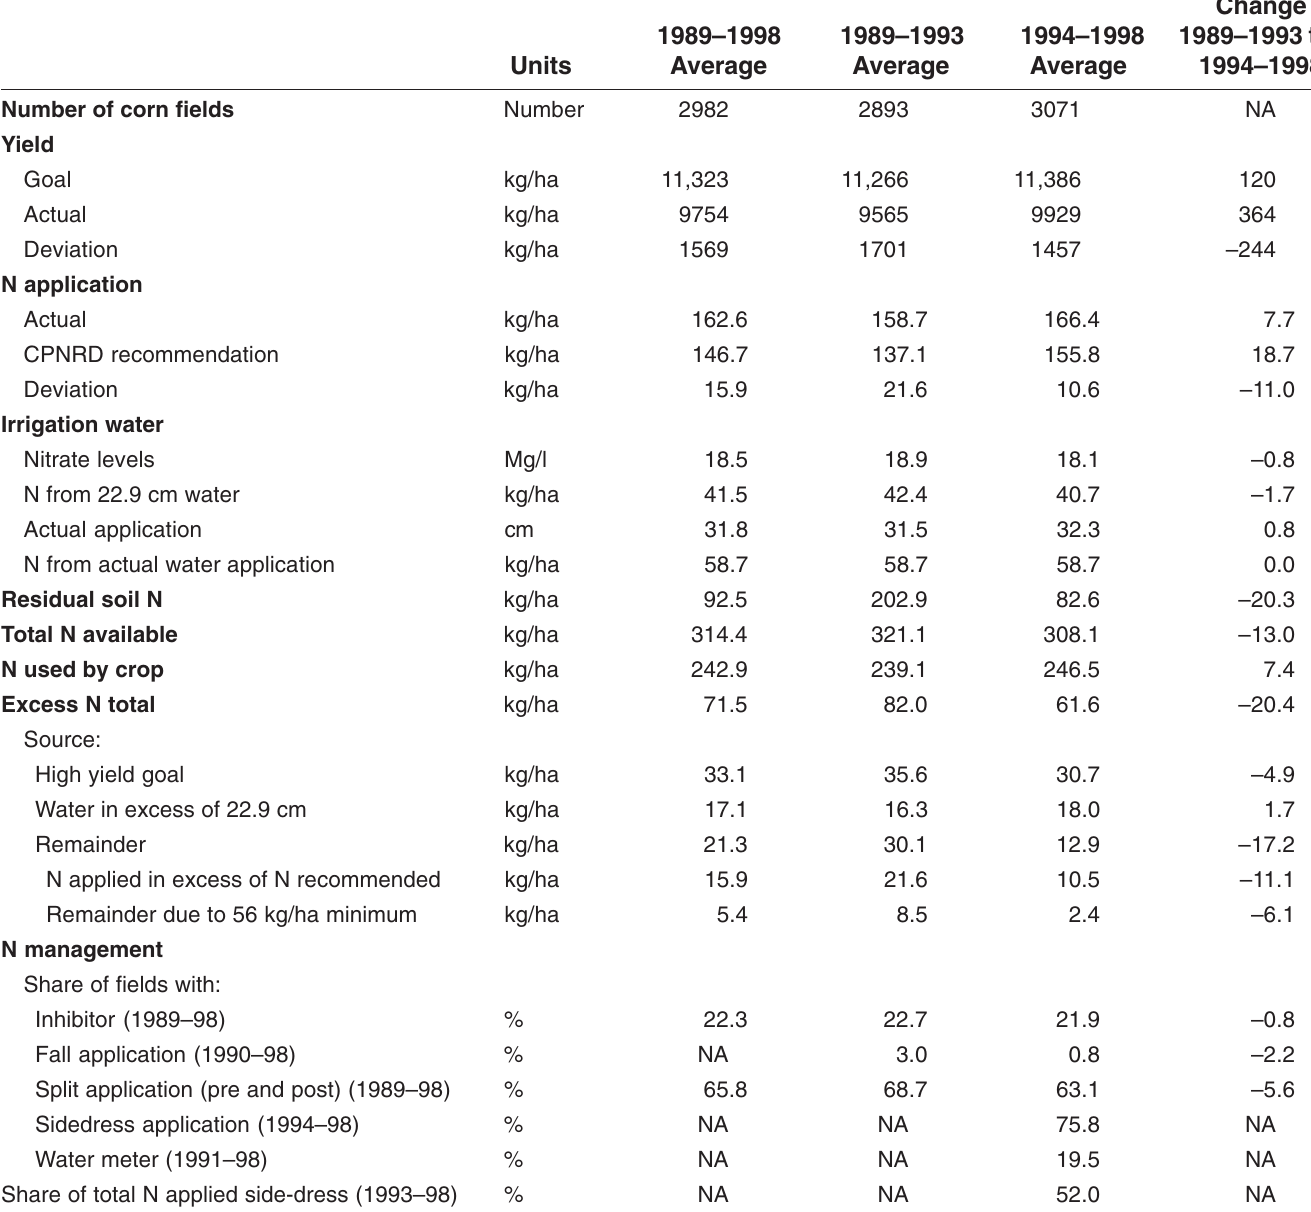
Selected CPNRD Corn Production and Nitrogen Management Data,